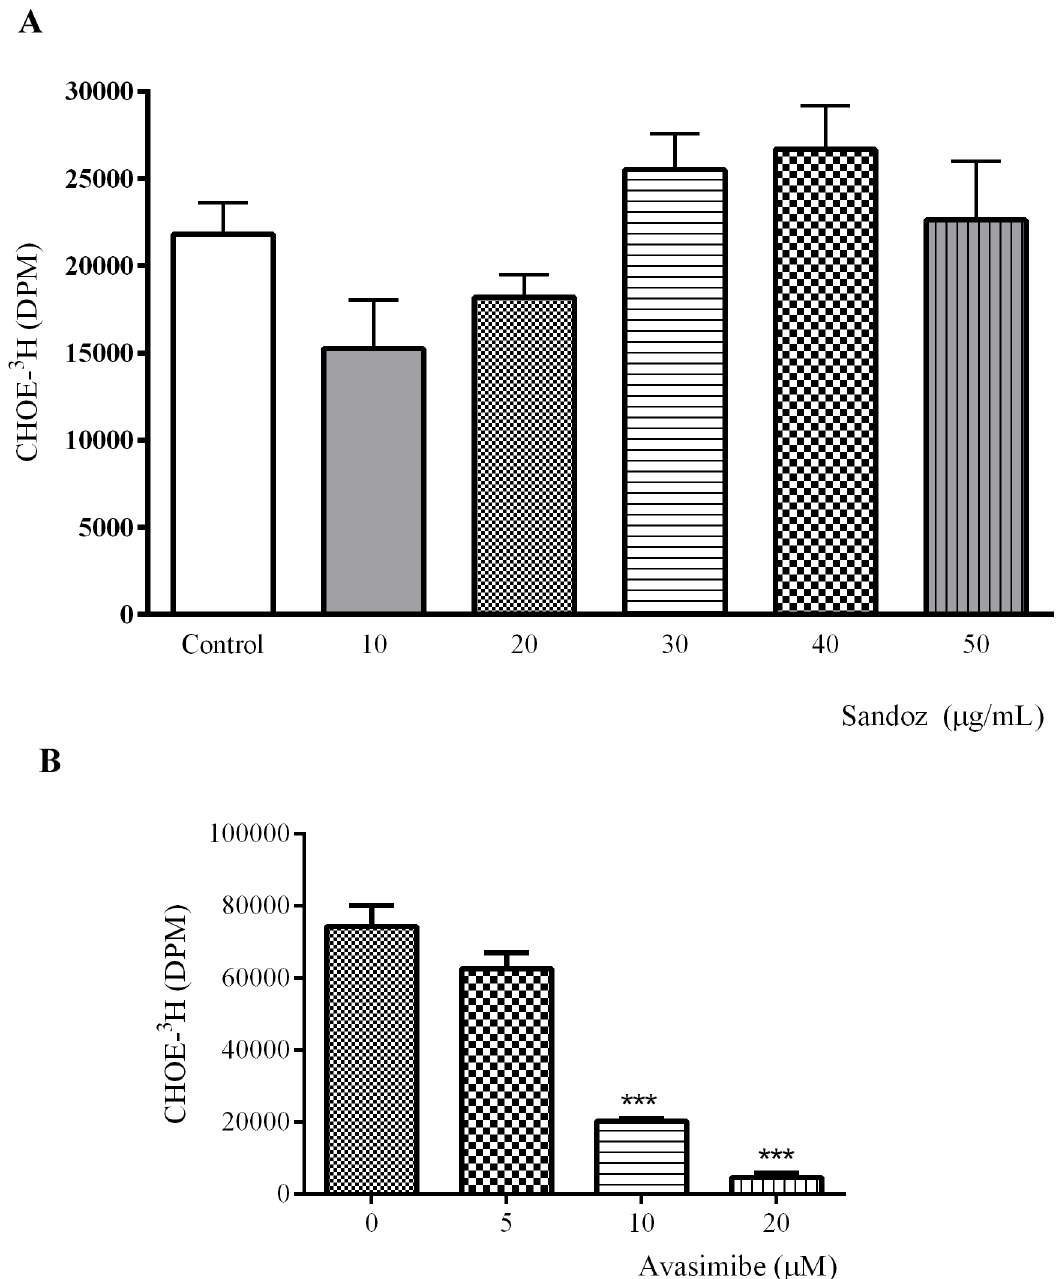
Fig 5. ACAT-related activity assay. The ability of T . cruzi epimastigotes to esterify cholesterol was tested using Sandoz 58-035-58-035 for 16 – 18 h (A) or Avasimibe for 24 h (B) in different concentrations, followed by addition of BSA- 3 H-palmitate (800,000 DPM; 1 mg/mL) for 24 h. Lipid analysis was performed by TLC; CHOE spots were scraped and the lipid eluted from silica. The lipid-associated radioactivity was measured by liquid scintillation counting. The results are expressed as the mean ( ± SD) per 1 mg of protein of two independent experiments in duplicate, and analysed by one-way ANOVA followed by the Bonferroni test ( * P <